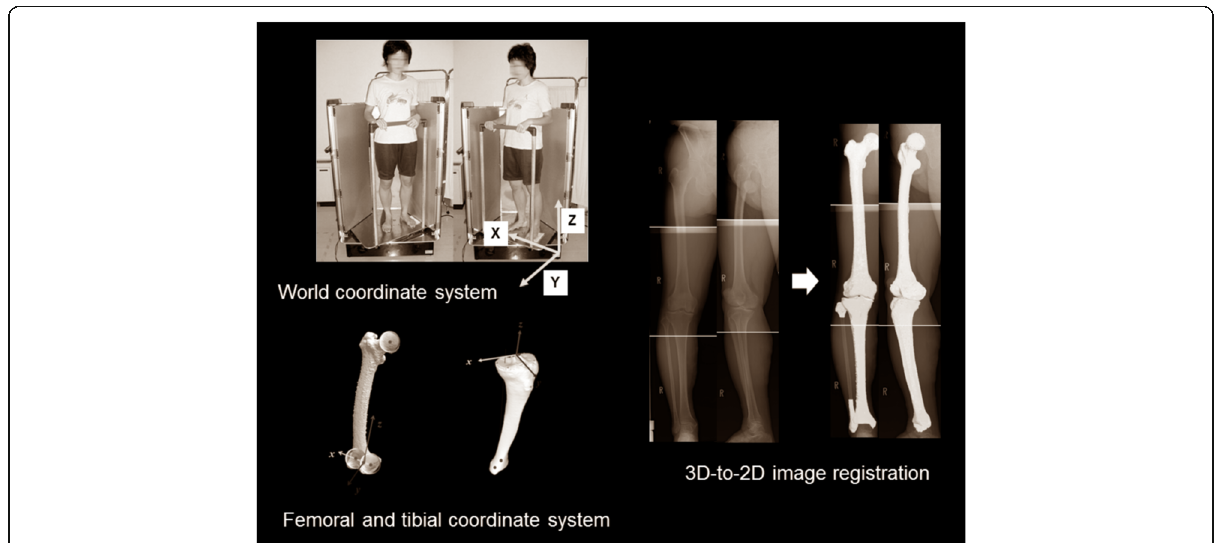
Fig. 3 The 3D lower extremity alignment assessment system under WB conditions based on biplanar long lower extremity radiographs, applying the 3D-to-2D image registration techniques. 3D bone models and the anatomic coordinate system of the femur and tibia were reconstructed. The 3D bone model included the definitions of the parameters in the bony morphology and whole lower extremity alignment. To assess the 3D parameters “ in the standing position ” under WB conditions, biplanar long lower extremity radiographs were obtained in the standing position. Applying the 3D-to-2D image registration technique, projected outline points of each 3D model were the finite edge points of the 2D shadow created from the projections of all visible triangular surfaces of the 3D model. To precisely assess the position and angle to the ground, the world coordinate system was